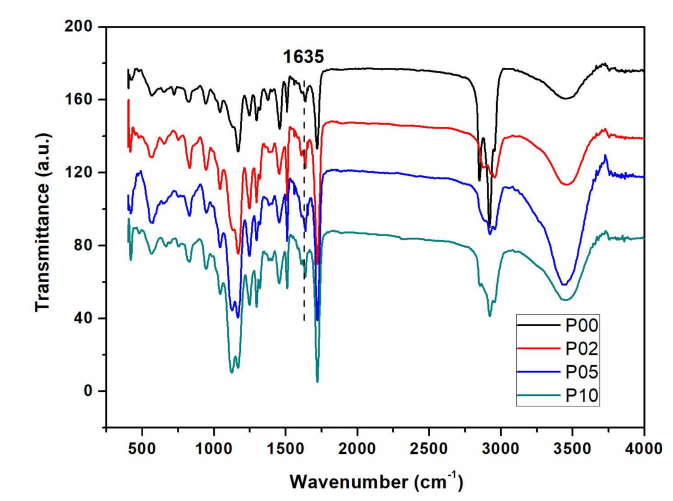
Figure 3. FTIR spectra of composite resins with different POSS additions.